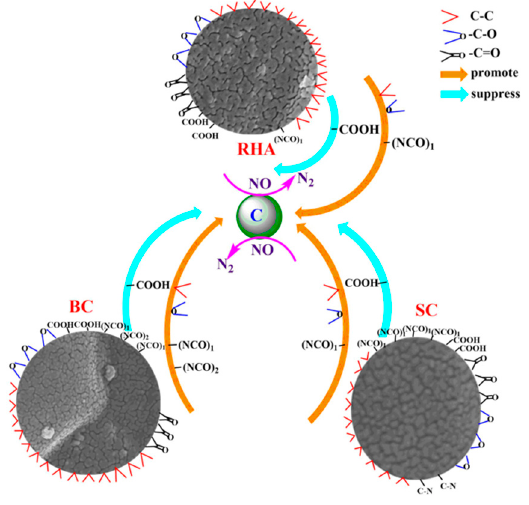
Figure 7. Mechanism of C-NO reduction.